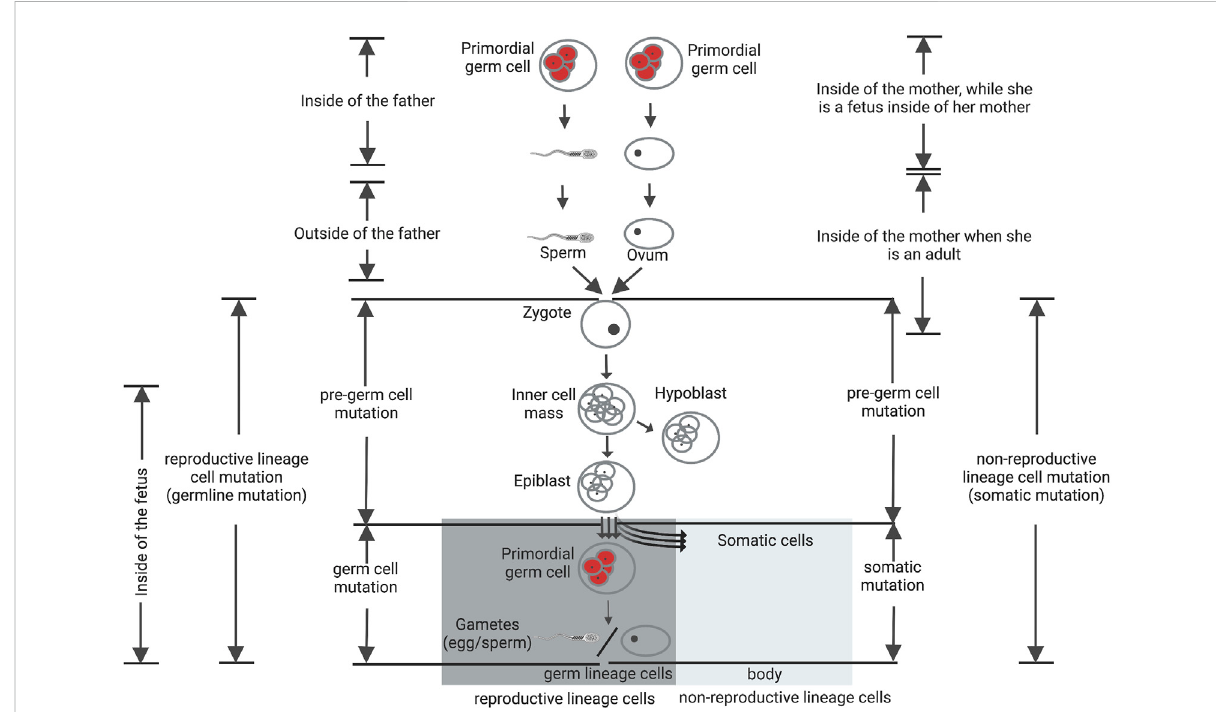
FIGURE 3 Reproductiveandnon-reproductivelineage cellsand denovo mutations. Mutations that occur inthereproductive lineage fromafertilized egg to gametes can be de fi ned as reproductive lineage cell mutations and categorized into two groups: pre-germ-cell-stage mutations (gonosomal mutation)andgerm-cell-stagemutations.Thegerm-cell-stagemutationsariseintheprimordialgermcells(pGCs)andtheiroffspringafterthepoint of divergence from somatic cells, usually being designated as germline mutations. Gonosomal mutations arise before this point of divergence. These mutations can exist in both somatic cells and gametes at the same time. The mutations that arise in the non-reproductive lineage cells, after thestageofdivergencefromgermlineage cells, are designated assomatic cellmutationsand areunable to transmit to theoffspring.Figure adapted from Sakumi